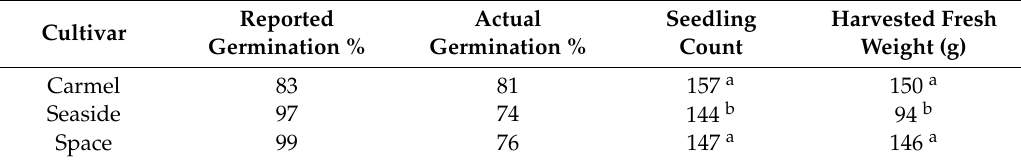
Table 4. Effects of Carmel, Seaside, and Space cultivars on germination and harvested fresh weight yield with all cells seeded in a [1, 2, 1, 2] seeding pattern (195 seeds planted). Different superscripts indicate significant differences between treatments by Tukey–Kramer paired t -tests at α = 5%.